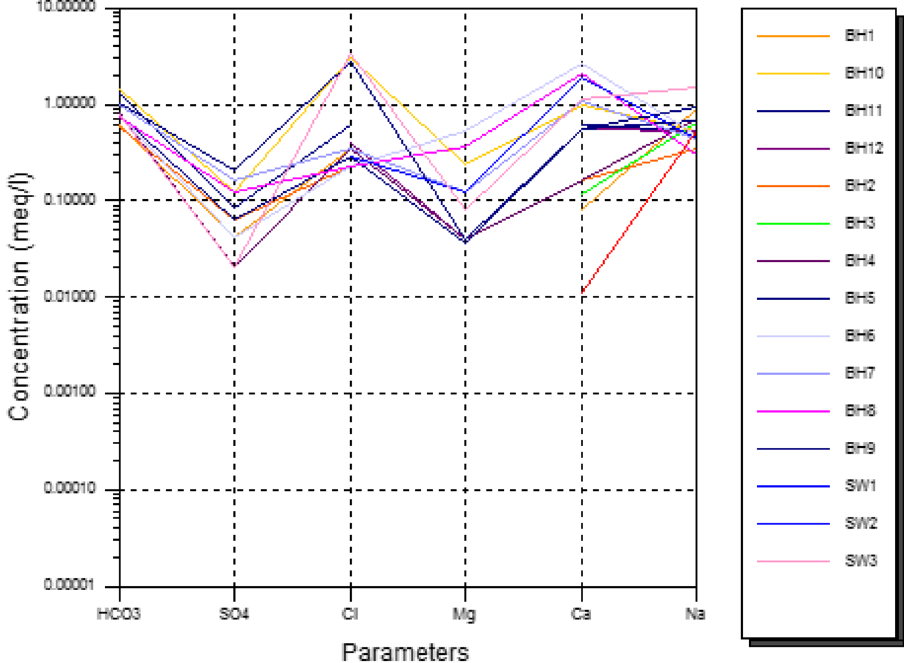
Fig. 3 Schoeller diagram show- ing the concentrations of major